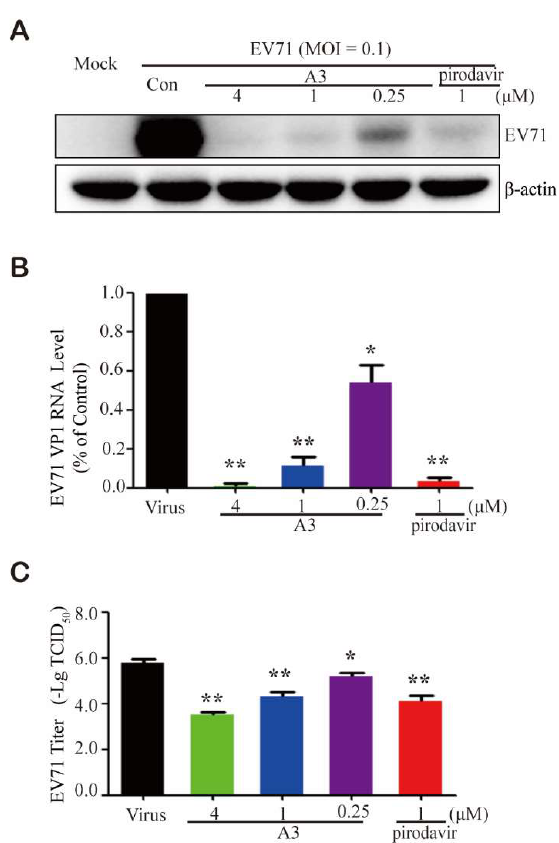
Figure 2. Compound A3 inhibited EV-A71 replication in vitro. Vero cells (9 × 10 5 cells/well) were plated into 6-well culture plates and infected with EV-A71 (multiplicity of infection, MOI = 0.1) for 1 h. The infected cells were then treated with the indicated concentrations of A3 for 24 h. Intracellular viral VP1 protein ( A ) and RNA ( B ) were determined by Western blot and qRT-PCR assays, respectively. ( C ) The inhibition of a viral titer by A3 . ** p < 0.01 * p < 0.05.